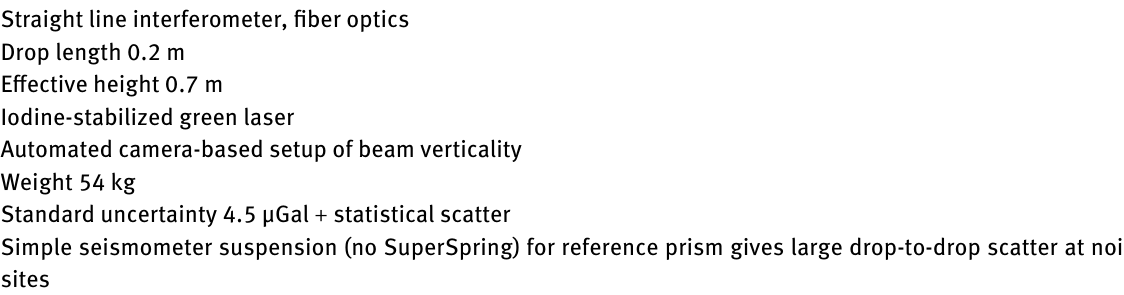
Table 2: Main features of the GABL-PM, GABL-M, GBL-M 002 gravimeters. (1 µGal = 10 −8 m s −2 ) Straight line interferometer, fiber optics Drop length 0.2 m